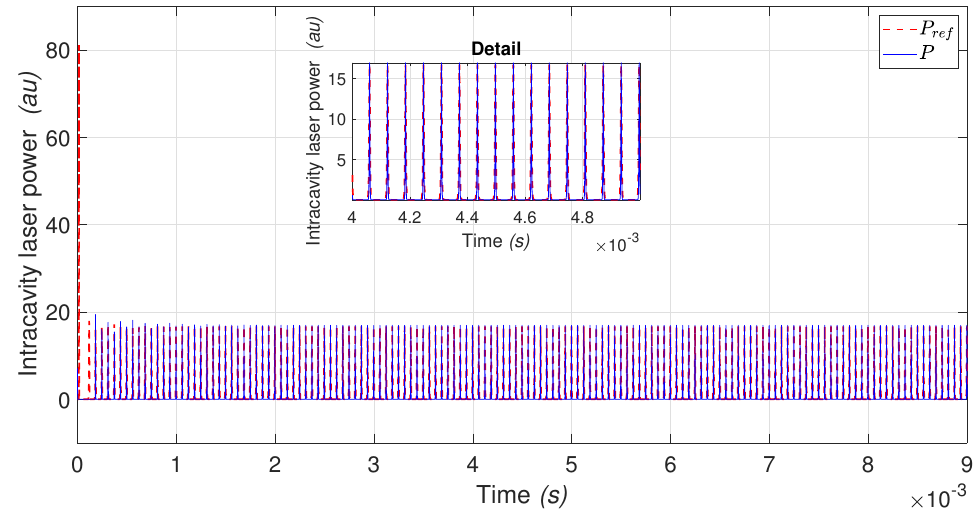
Figure 11. EDFL tracking to P